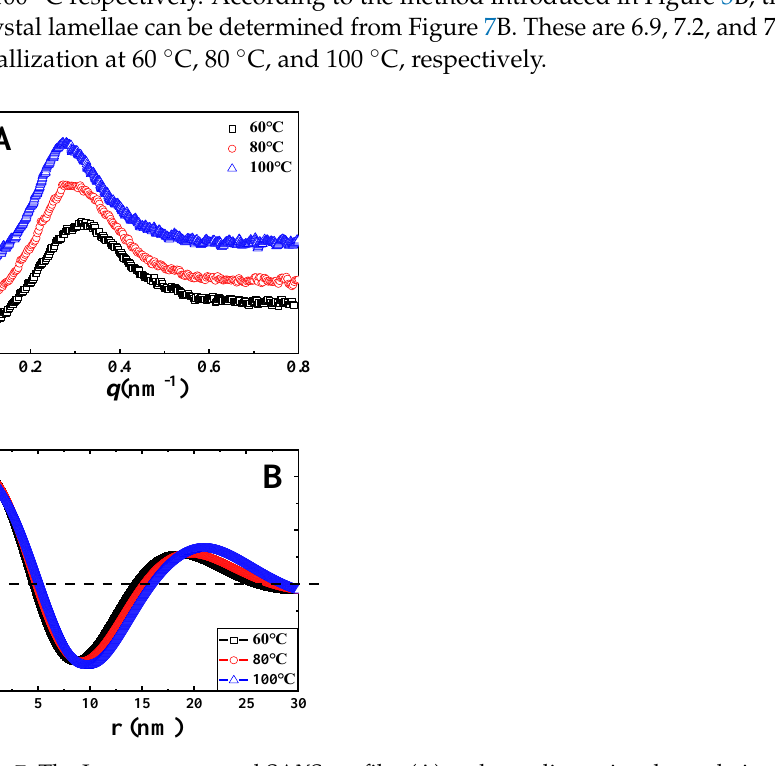
1.47 Figure 8. SEM images of PLLA/TAIC (60/40) blend upon etching with methanol on the specimen upon complete cold crystallization at 60 °C ( A ), 80 °C ( B ), and 100 °C ( C ).